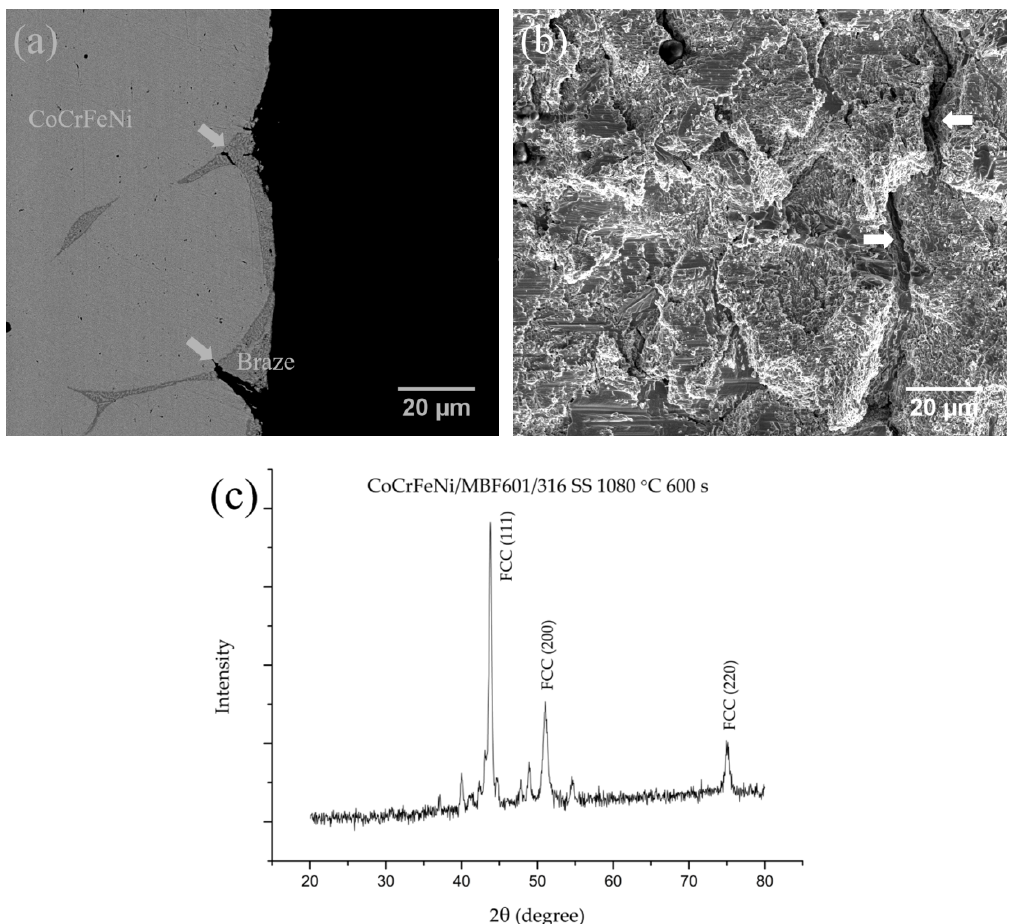
Figure 12. SEM ( a ) cross-section, ( b ) fractograph and ( c ) XRD pattern of CoCrFeNi/MBF601/316 SS joint infrared brazed at 1080 °C for 600 s.